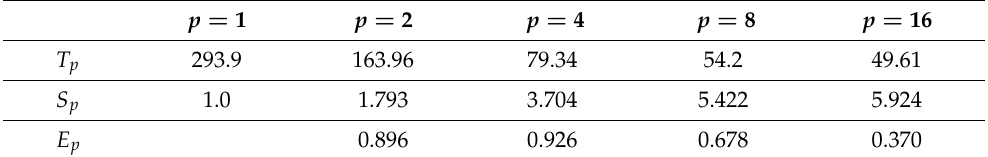
Table 7. The AAA algorithm (19): the values of the speedup S p and efficiency E p numbers for τ = 0.025, α = 0.5 and different numbers of cores. The order of the AAA algorithm is fixed to m =